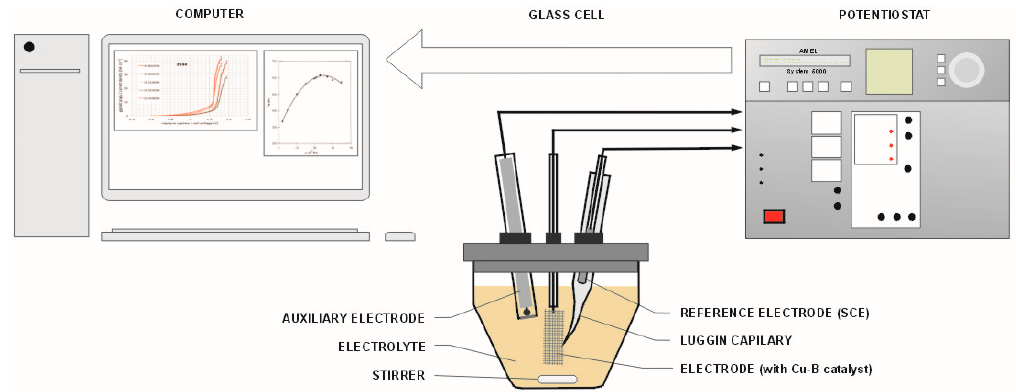
Figure 15. Schematic view of the reactor for the measurement of the electroless potential and the influence of anodic charge of electrodes with a Cu–B catalyst.